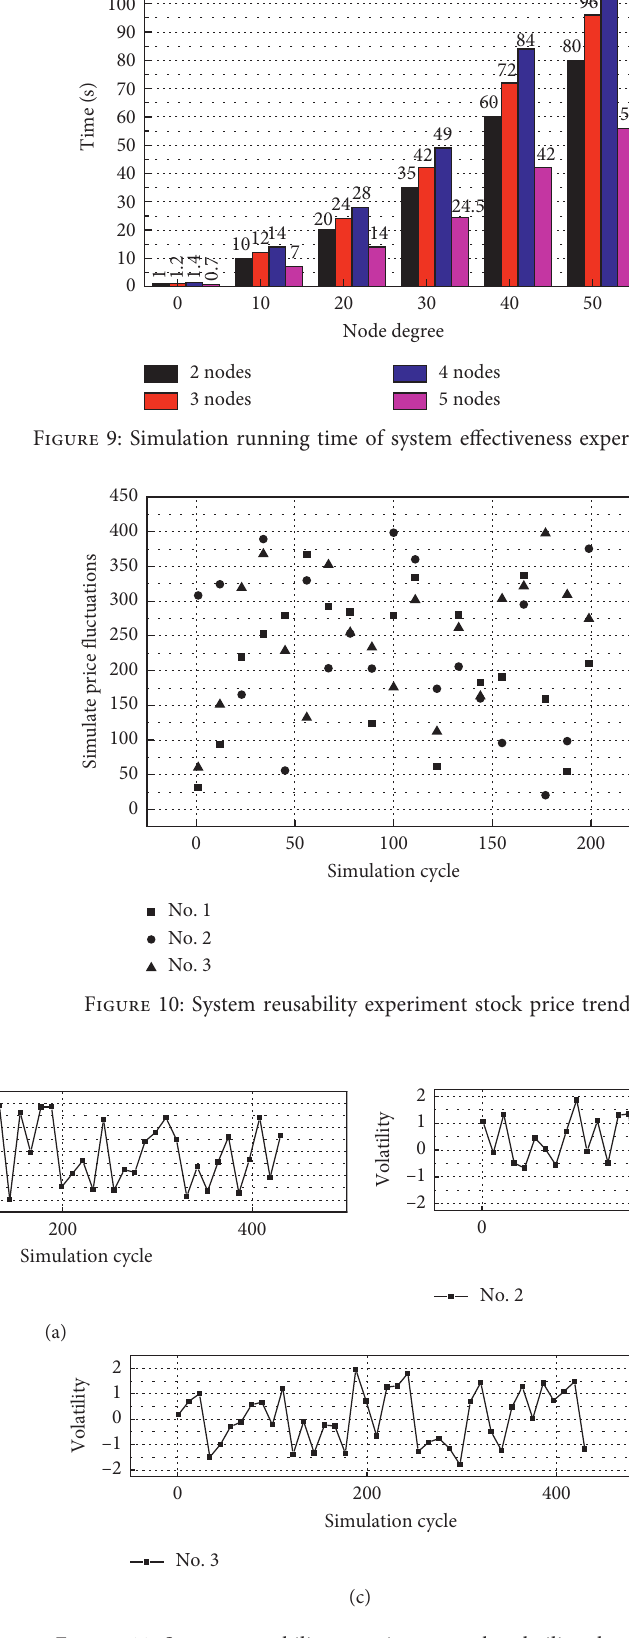
Figure 11: System reusability experiment stock volatility